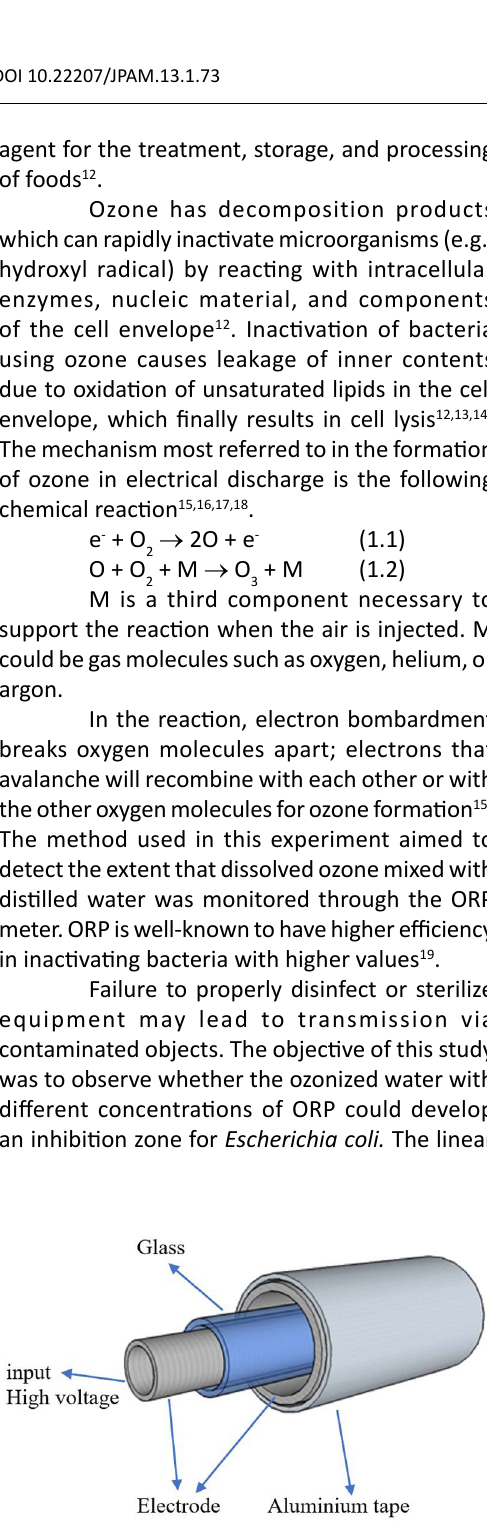
Fig. 1. Dielectric Barrier Discharge model. [Change aluminum to aluminum. Change to High voltage